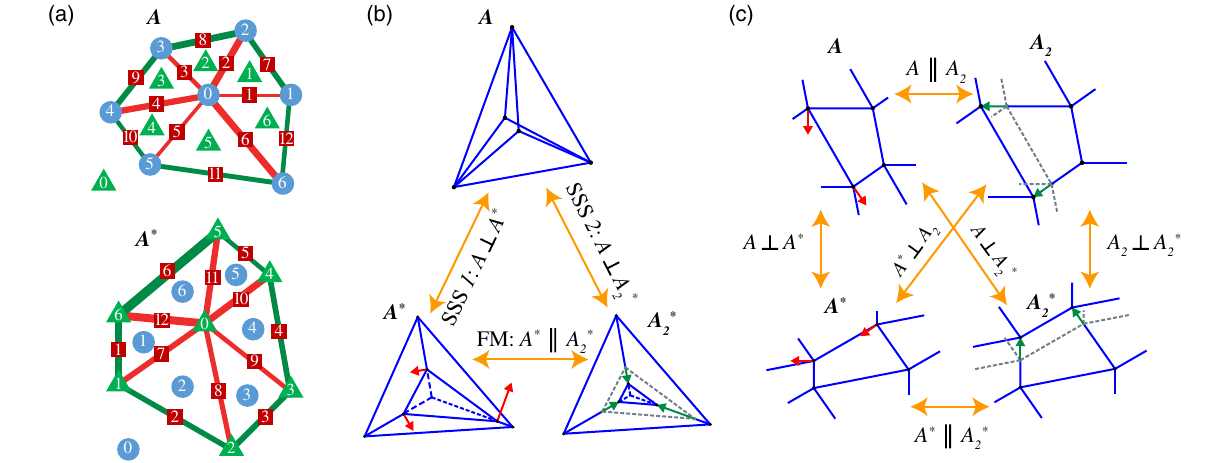
FIG. 9. Maxwell reciprocal diagrams and the mechanical duality theorem. (a) A pair of reciprocal diagrams A ⊥ A (cid:2) . Edges (marked by squares) corresponding to one another are labeled by the same number in A and A (cid:2) . Nodes in A (circles) correspond to faces in A (cid:2) (including the exterior face) with the same number. Faces in A (triangles) correspond to nodes in A (cid:2) with the same number. Equilibrium stresses that generate the reciprocal are marked by the thickness of the edges, and the red and green colors correspond to two signs of tension. (b) Two SSSs of frame A lead to its two reciprocal diagrams A (cid:2) ; A (cid:2) 2 . This shows an example of the mechanical duality theorem discussed in Appendix E: FMs of A (cid:2) and SSSs of A (except for the one that generates A (cid:2) ) have a one-to-one mapping — they both correspond to A (cid:2) 2 . The irrotational and FM displacements ⃗ v and ⃗ u are shown by green and red arrows, respectively (defined in Appendix E). (c) Reciprocal relations between periodic lattices. Any Maxwell lattice A must have at least two SSSs at ⃗ q ¼ 0 [as we discuss at Eq. (D6)], leading to two reciprocal diagrams A (cid:2) and A (cid:2) 2 , which are both Maxwell lattices as well with the same periodicity. Each of A (cid:2) and A (cid:2) 2 must also have at least two SSSs leading to A and A 2 . As we discuss in Appendix E, because A k A 2 and A (cid:2) k A (cid:2) 2 , they are related by irrotational displacements ⃗ v (green arrows) and the corresponding FM ⃗ u (red arrows) which belong to a group of FMs in Maxwell lattices called the Guest-Hutchinson FMs (see Ref.